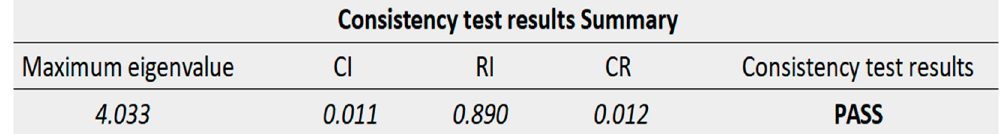
Figure 6. Consistency test.